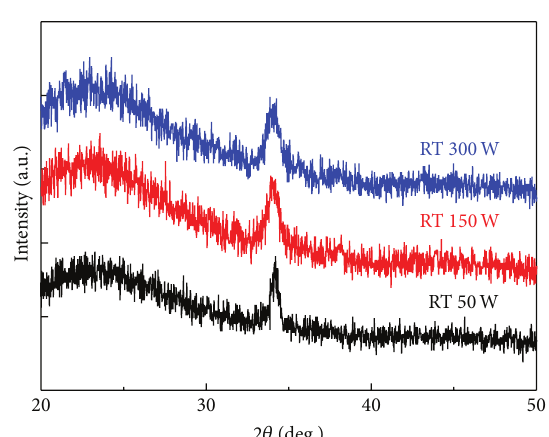
Figure 2: X-ray diffraction spectra of ZnO films grown by using RF power of 50, 150, and 300